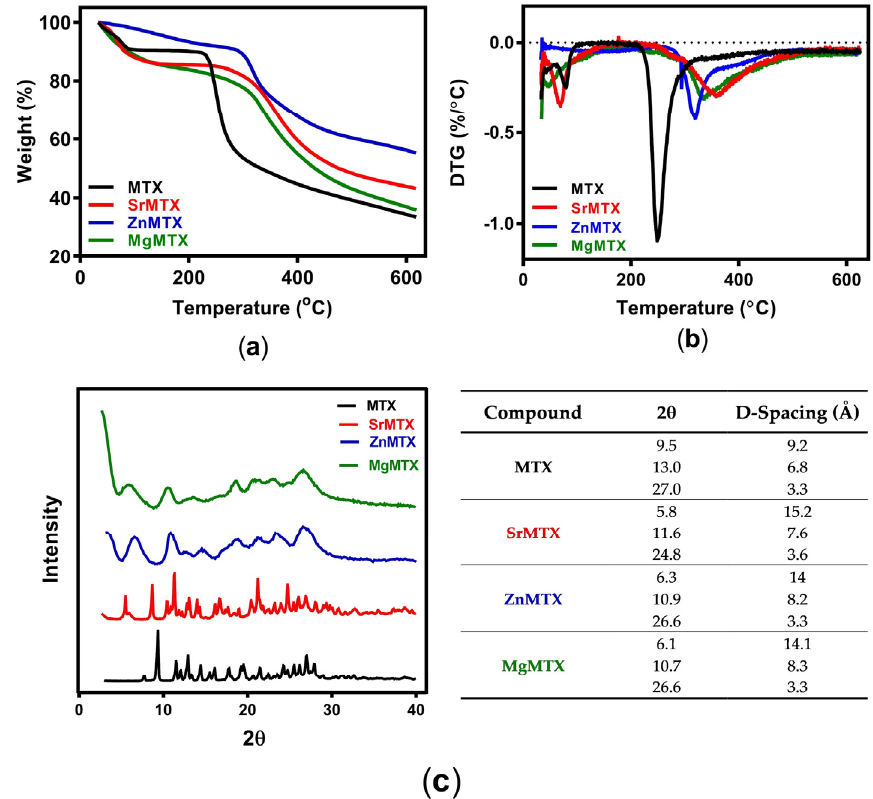
Figure 3. Physicochemical characterization of MTX and its derivatives: ( a ) TGA analysis; ( b ) DTG; ( c ) XRD analysis and main reflection peaks with calculated D-spacing.